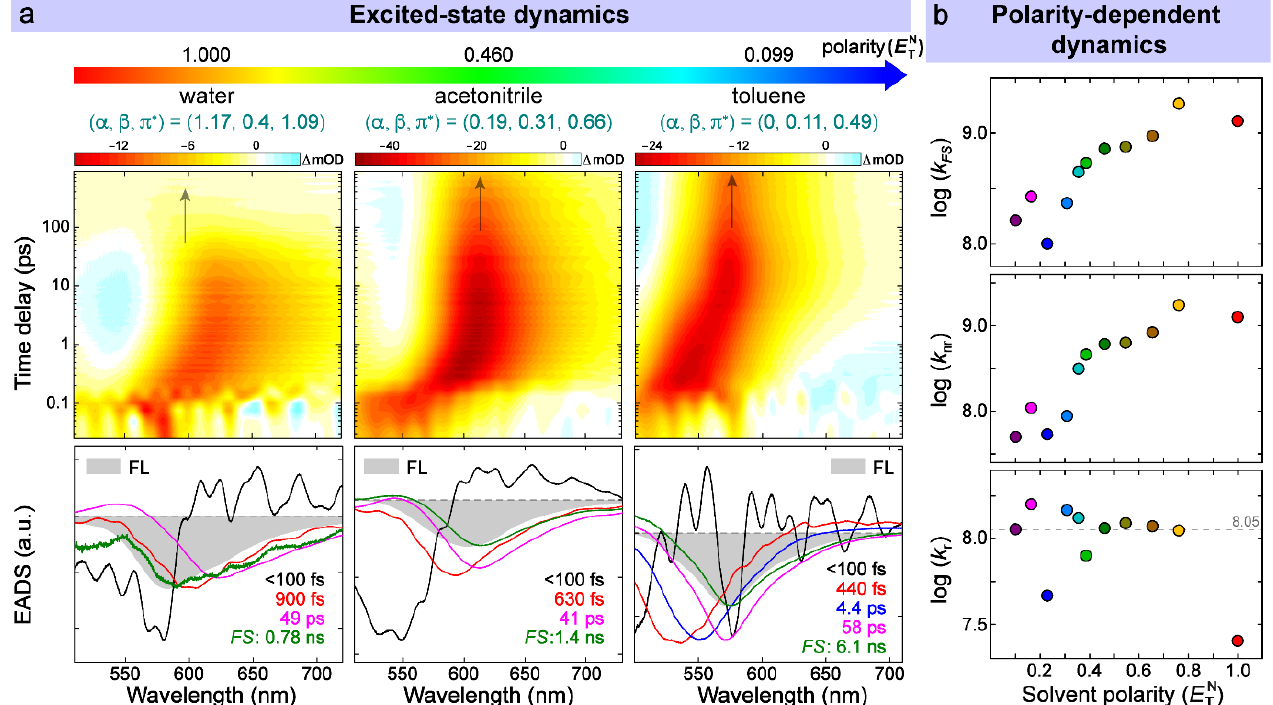
Figure 3. Excited-state dynamics and decay rate constants of the newly designed polarity sensor. ( a ) Semilogarithmic contour plots and global analysis of fs-TA spectra for compound 1 in solvents with decreasing polarity. The arrow in each contour plot denotes the position and decay of the relaxed FS. The lifetimes retrieved from global analysis are color-coded in accordance with the corresponding EADS. Steady-state fluorescence spectrum is inversed and overlaid as a gray shaded band for each sample. ( b ) Relationships between the observed decay rate constants and intrinsic solvent polarity (cid:1831) (cid:3021)(cid:3015) . The colors for solvents are defined the same way as Figure 1.